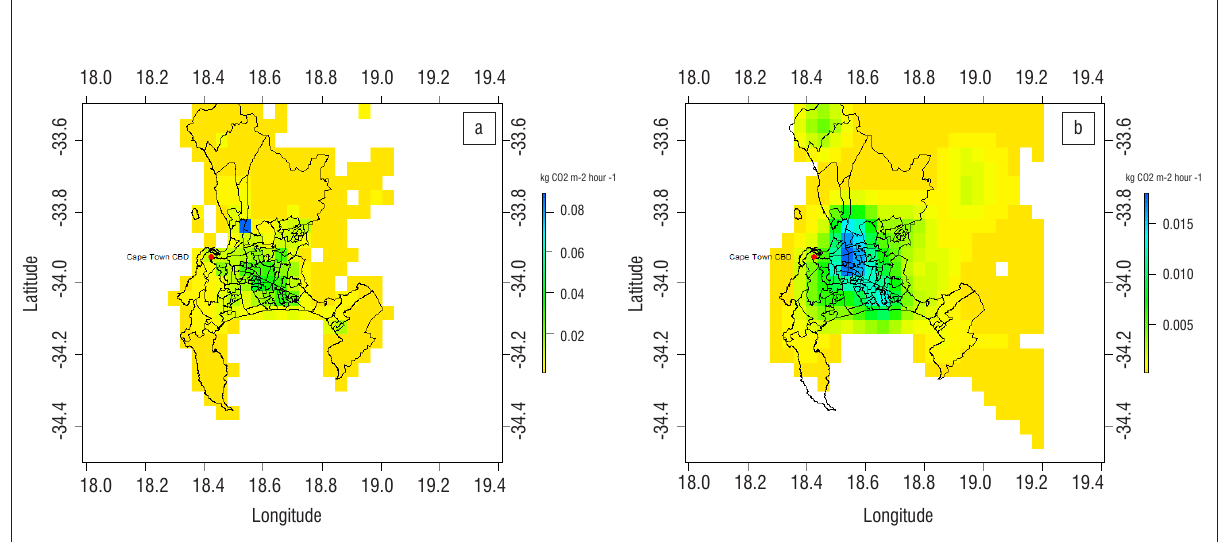
Figure 10: Comparison of (a) emissions estimated from the spatial and temporal disaggregation approach and (b) EDGAR emissions for the year 2010 over the City of Cape Town. Emissions are presented as kg CO per m 2 per 2